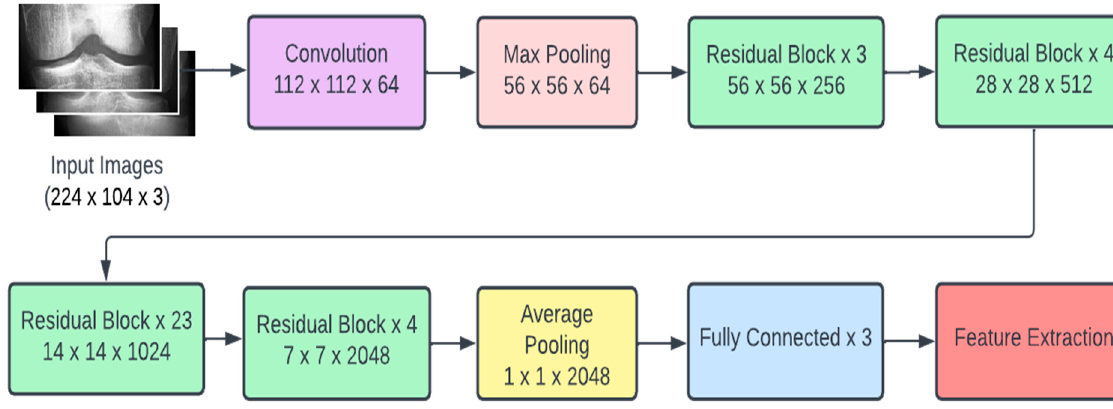
Figure 3. ResNet101